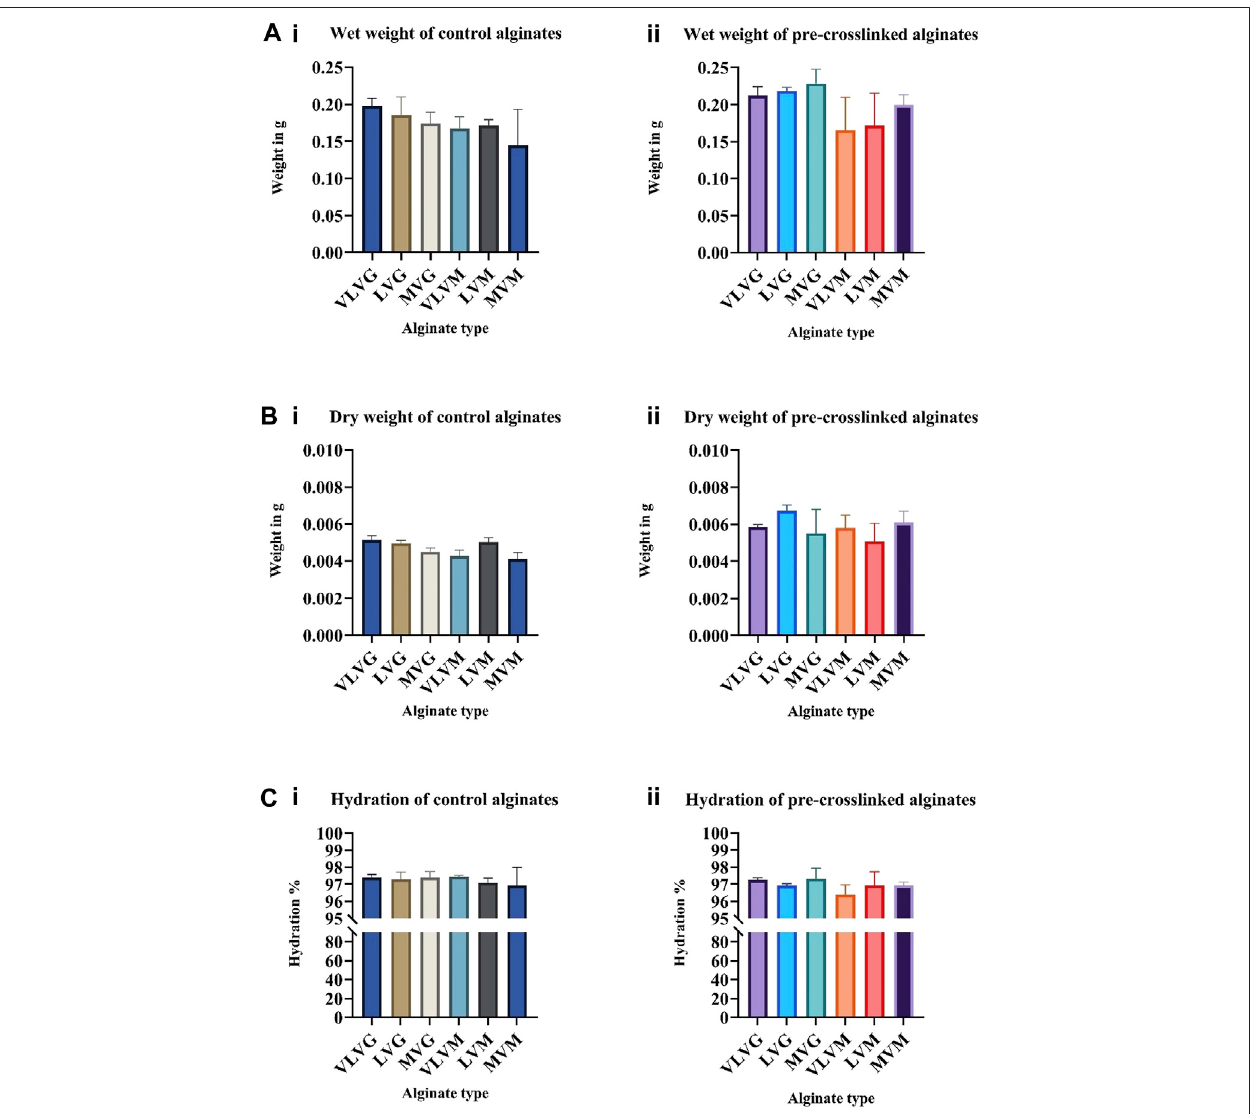
FIGURE 1 | The effect of alginate molecular weight, G:M ratio and pre-crosslinking on the hydration properties of bio-inks. Fibers were formed by wet spinning before assessing wet weight and dry weight of control (Ai,Bi) and pre-crosslinked (Aii,Bii) alginate fi bers. Weight values were used to calculate hydration % of control alginate fi bers (Ci) and pre-crosslinked alginate fi bers (Cii) . Values are expressed as mean ± SD from six separate experiments.